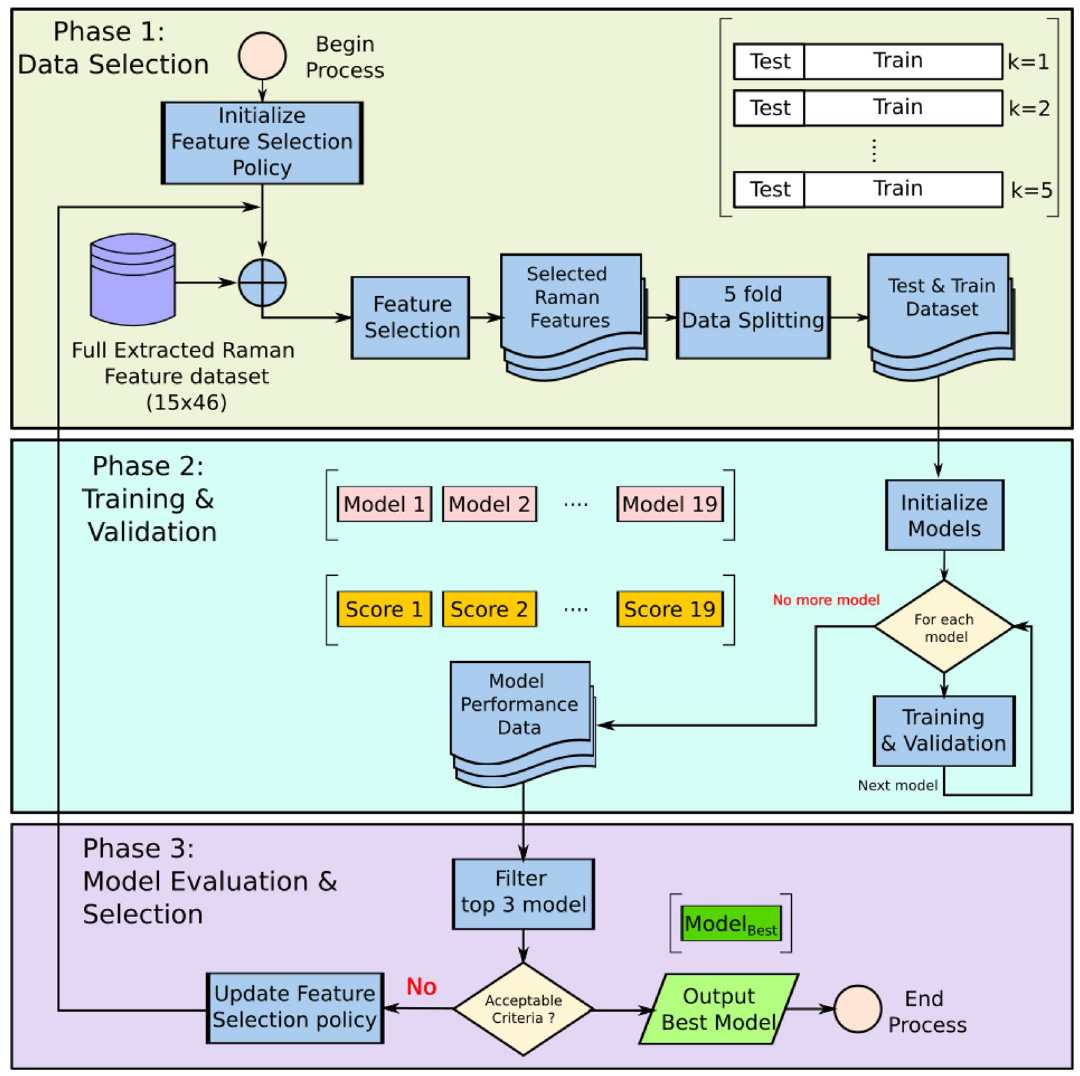
Figure 4. Classification analysis